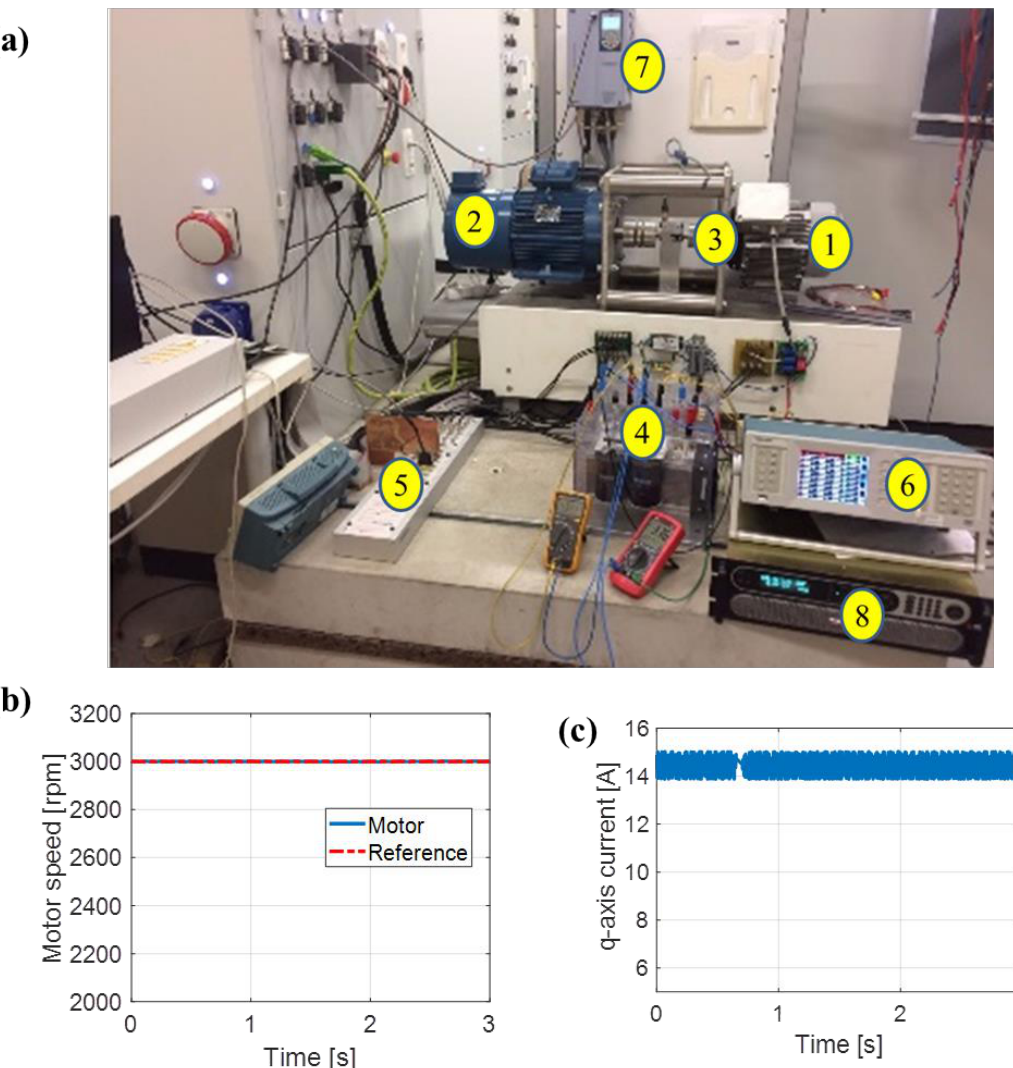
Figure 7. Experimental test bench ( a ); reference and motor speeds ( b ); q-axis current ( c ). An induction motor controlled via a commercial drive (7) is used for emulating the pump loading conditions, while a controlled DC supply (8) is used to emulate the PV array.